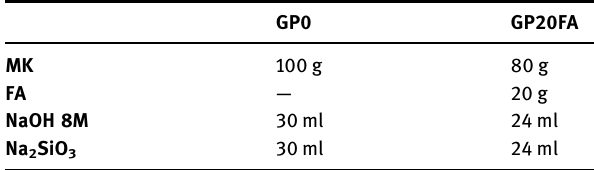
Table 2: Geopolymer sample